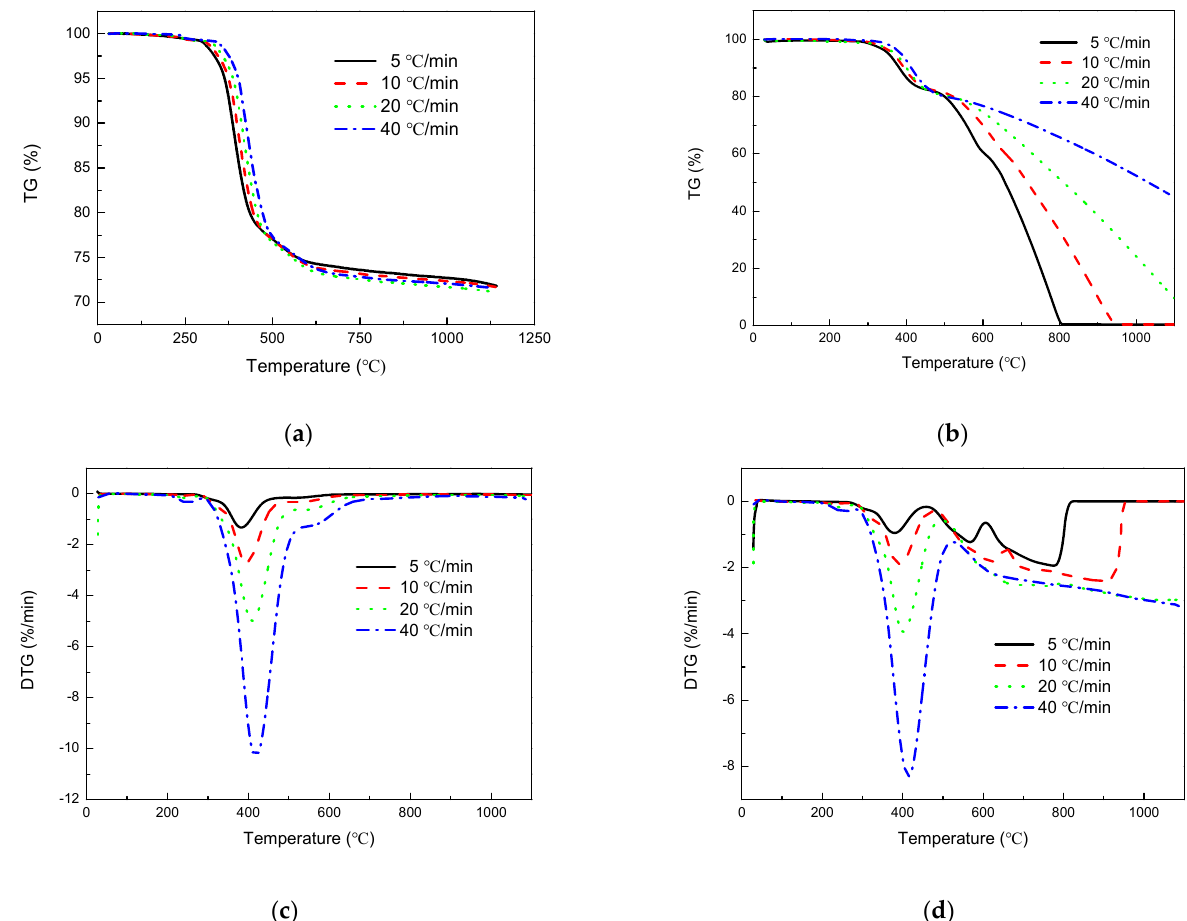
Figure 2. TG and DTG curves for the carbon/epoxy composite material carried out under inert and air atmosphere at 20 °C/min.